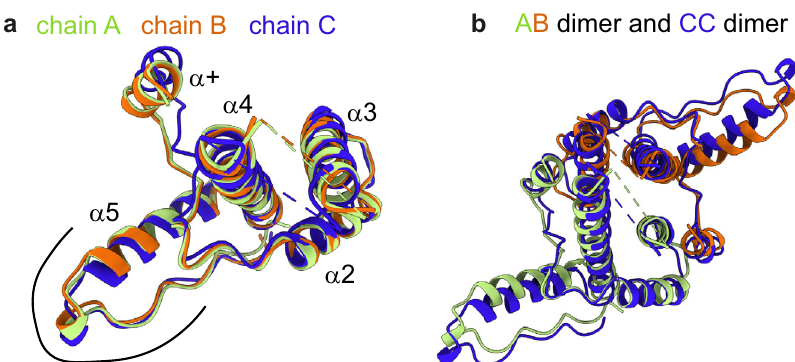
Fig. 3 | ACNDV Cp chains at pH 7.5. a Chain A, chain B, and chain C of ACNDV Cp at pH 7.5 superimposed by “ matchmaker ” implemented in ChimeraX 80 . The helix numbering convention is the same as in 1 and the hand region is delineated by a black line. b Superposition of the AB and CC